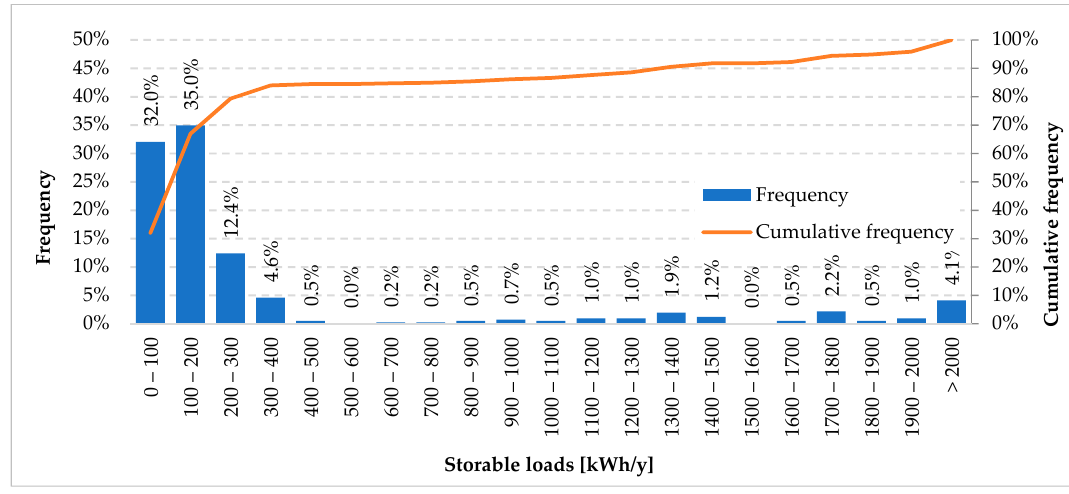
Figure 10. Storable loads.